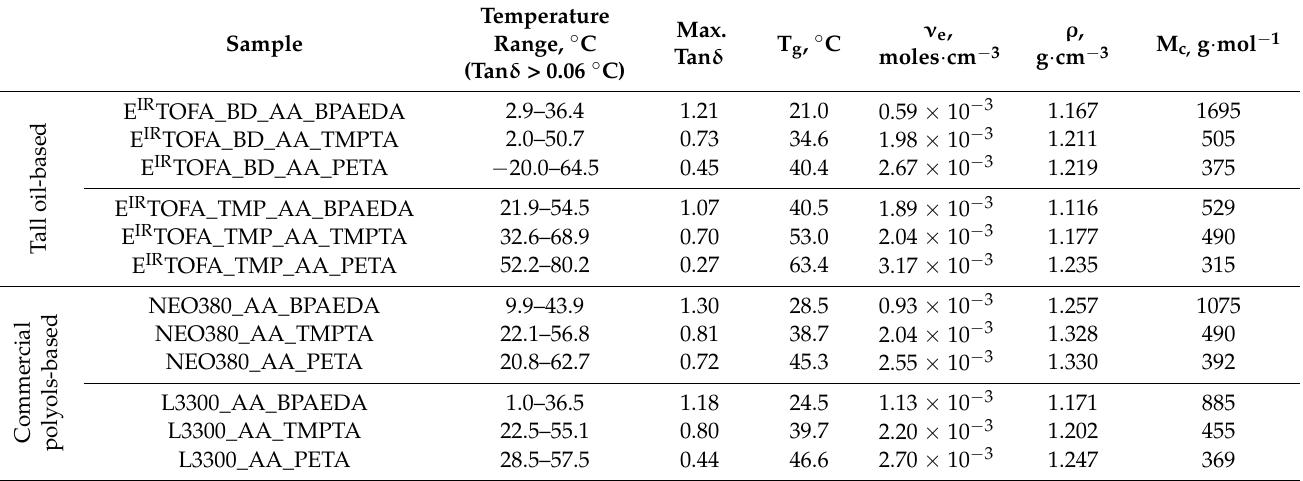
Table 2. Glass transition temperatures (T g ), cross-link density ( ν e ) and molecular weight between cross-links (M c ) from DMA tests and density ( ρ ) of polymer monoliths from tall oil polyol or com- mercial polyol-based acetoacetates and BPAEDA, TMPTA, and PETA acrylate.